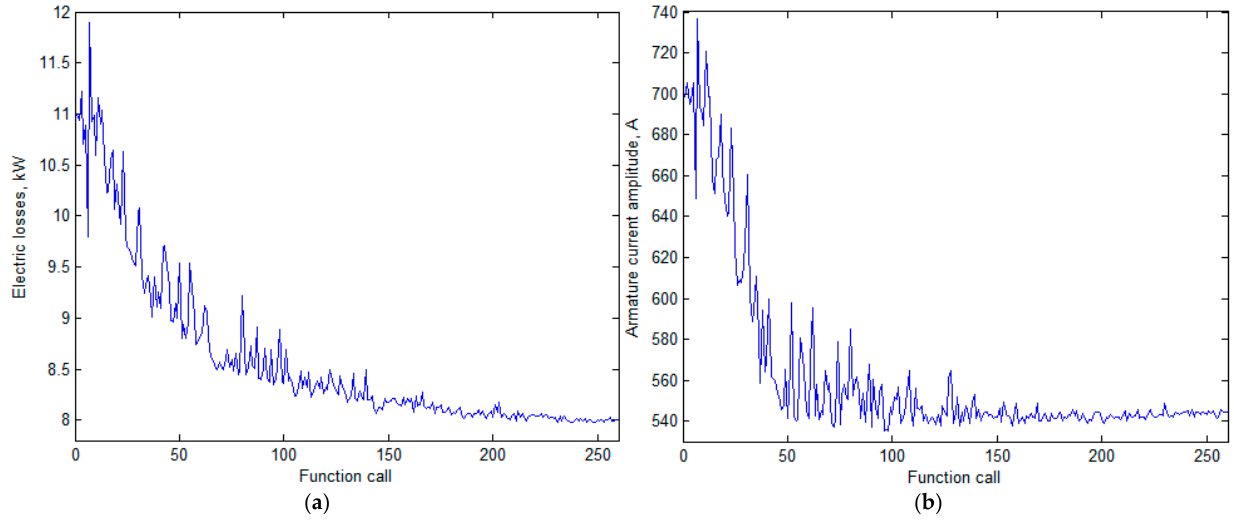
Figure 7. History of change of the target performances. ( a ) Average electrical loss; ( b ) Upper limit of the motor current.